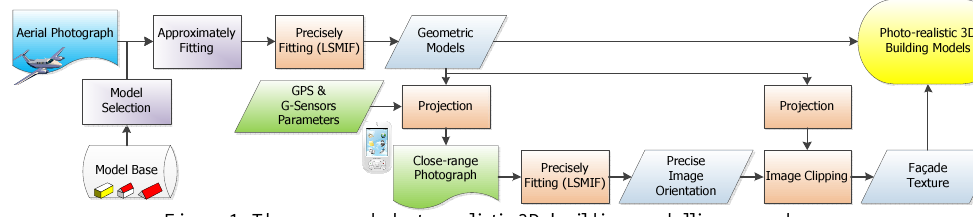
Figure 1: The proposed photo-realistic 3D building modelling